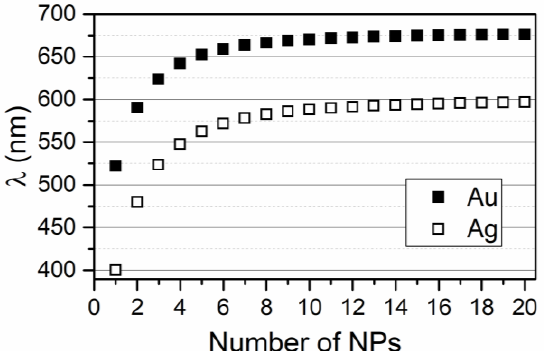
Figure 2. Lowest energy mode of the chain as a function of the number of NPs, for gold and silver NPs. Input data for AuNPs and AgNPs is, respectively, ω 0 = 2.375 eV, β = − 0.28 eV, ω 0 = 3.10 eV, and β = − 0.52 eV.